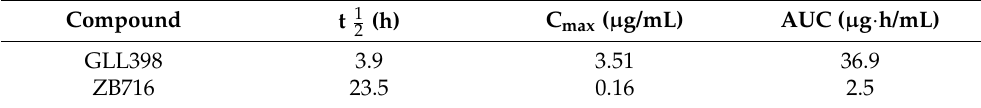
Table 2. The oral pharmacokinetic parameters of GLL398 and